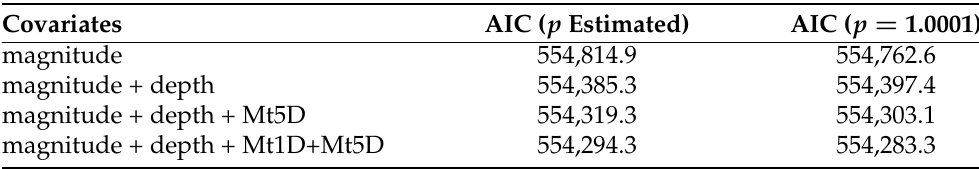
Table 3. AIC values. South catalog, p